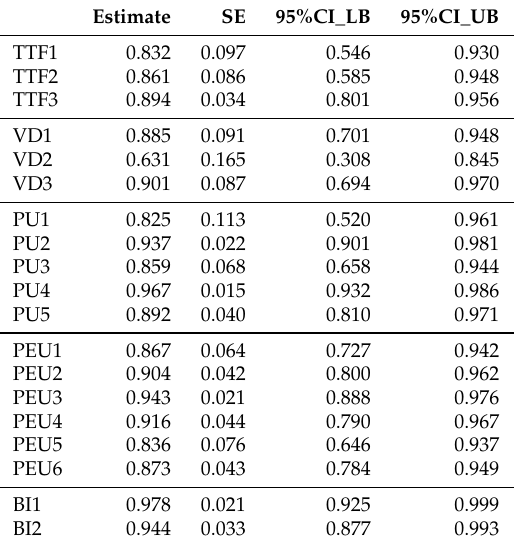
Table 5. Estimates of loadings.